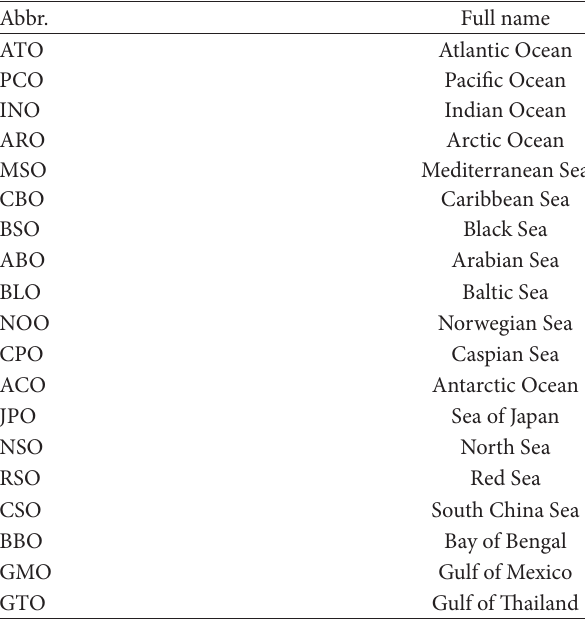
Table 3: Abbreviations of ocean nodes.